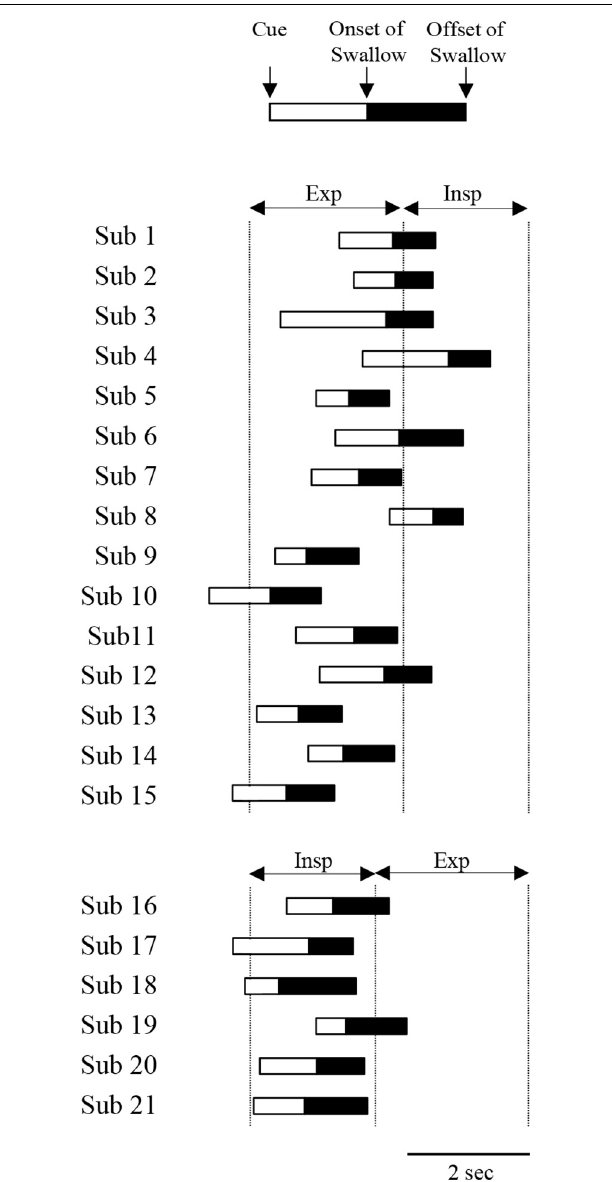
FIGURE 4 | Time of cuing, onset and offset of suprahyoid electromyography (EMG) burst during 3-ml water swallowing with cue. Participants 1–15 and 16–21 exhibited expiration–swallow–expiration (EE) type and inspiration–swallow–expiration (IE) type, respectively. The time was aligned with the onset of the expiratory phase for EE type and the onset of the inspiratory phase for IE type. Exp and Insp indicate the mean duration of expiratory and inspiratory phases at rest,